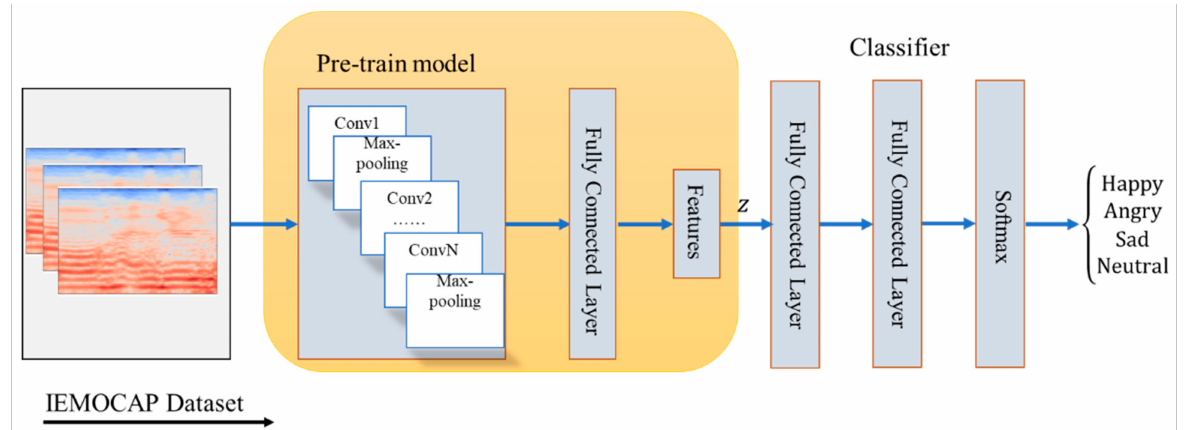
Figure 1. Architecture of the proposed research mechanism. The pre-train model derived from LibriSpeech and the features extracted from pre-train model are utilized for classification, which conducted the certain emotion of “Happy”, “Angry”, “Sad”, and